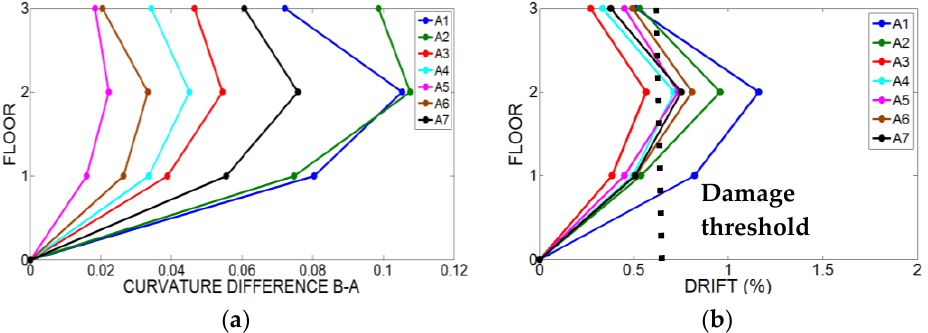
Figure 9. Structural damage localization for the numerical models. Results of the 3-story regular in plan structure: ( a ) curvature difference between the selected time-instants B and A; ( b ) inter-story drift and damage threshold equal to 0.5% (for non-structural components) valid for reinforced concrete framed structures.